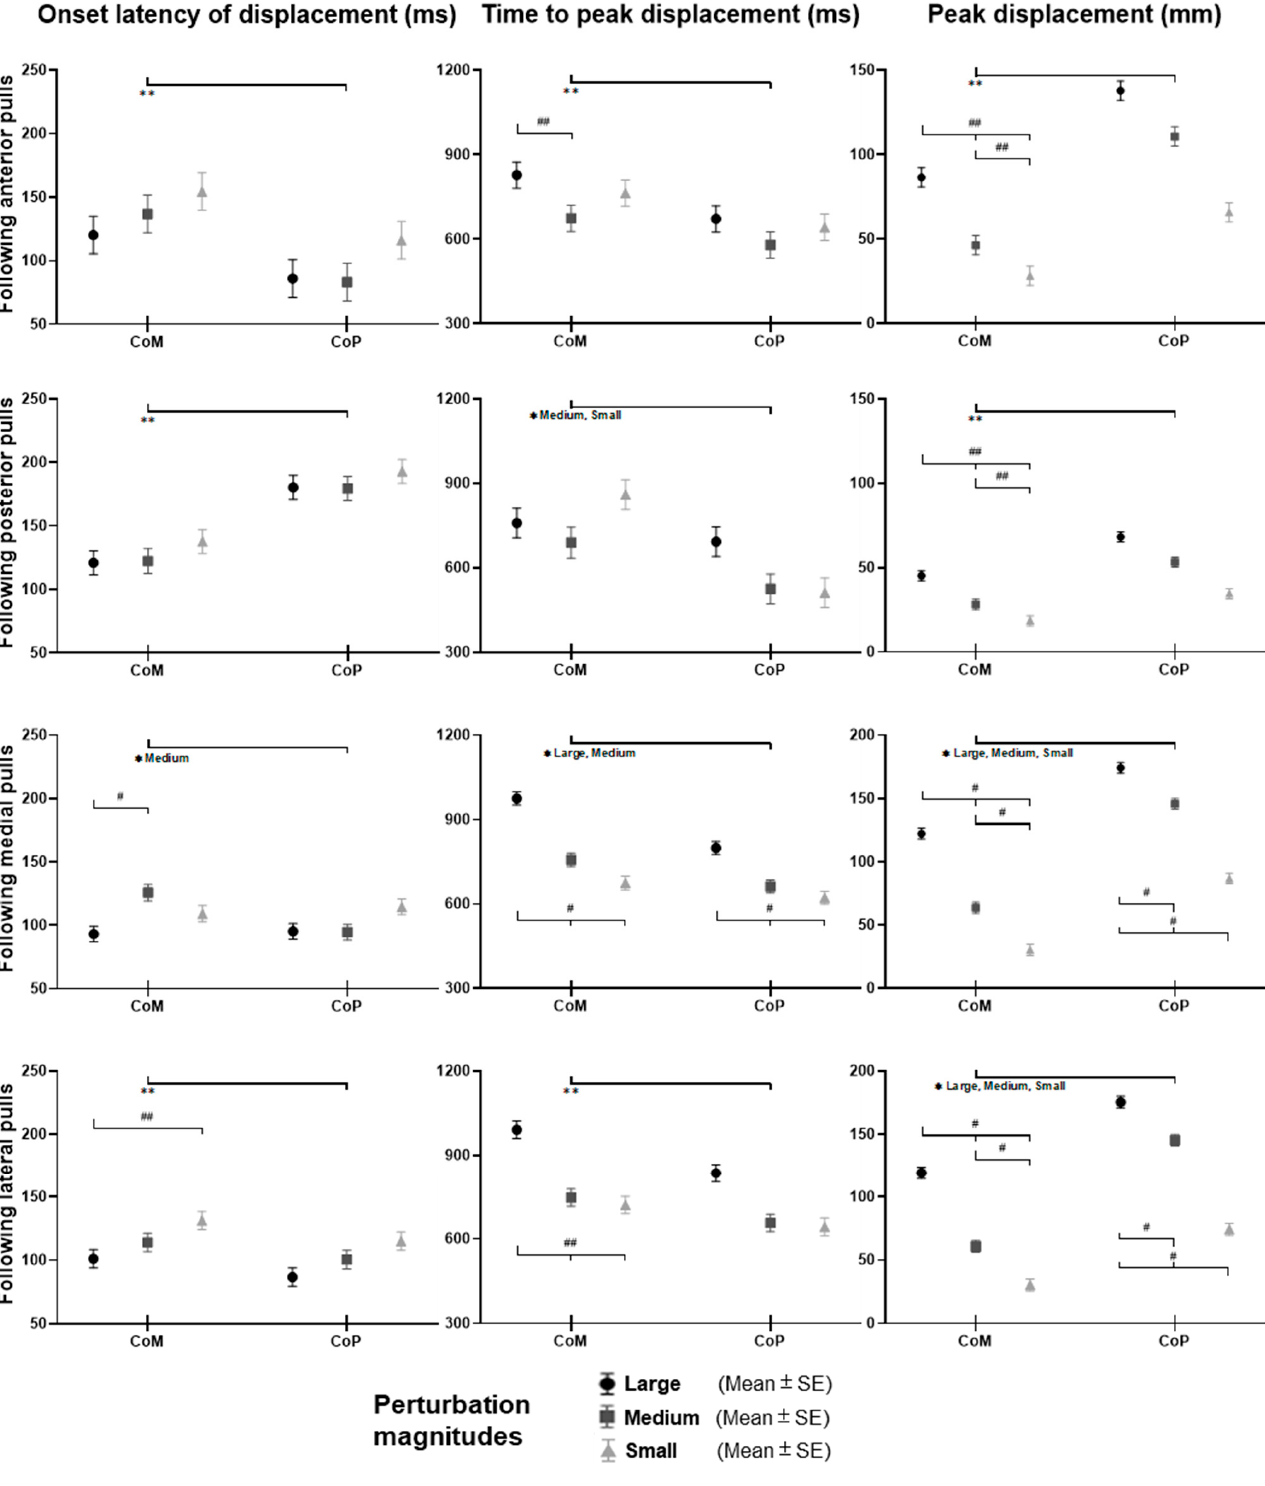
Figure 4. The onset latency of displacement, time to peak displacement, and peak displacement of whole-body CoM and CoP following unexpected horizontal perturbations (mean ± SE, n = 12). (Note: CoM : center of mass; CoP : center of pressure; SE : standard error; or : pairwise comparison. Significant differences in post hoc pairwise comparisons ( p < 0.05) were indicated by the: ** for the main effect of postural sway factor; * for the simple main effect of postural sway factor; ## for the main effect of magnitude factor; # for the simple main effect of magnitude factor).